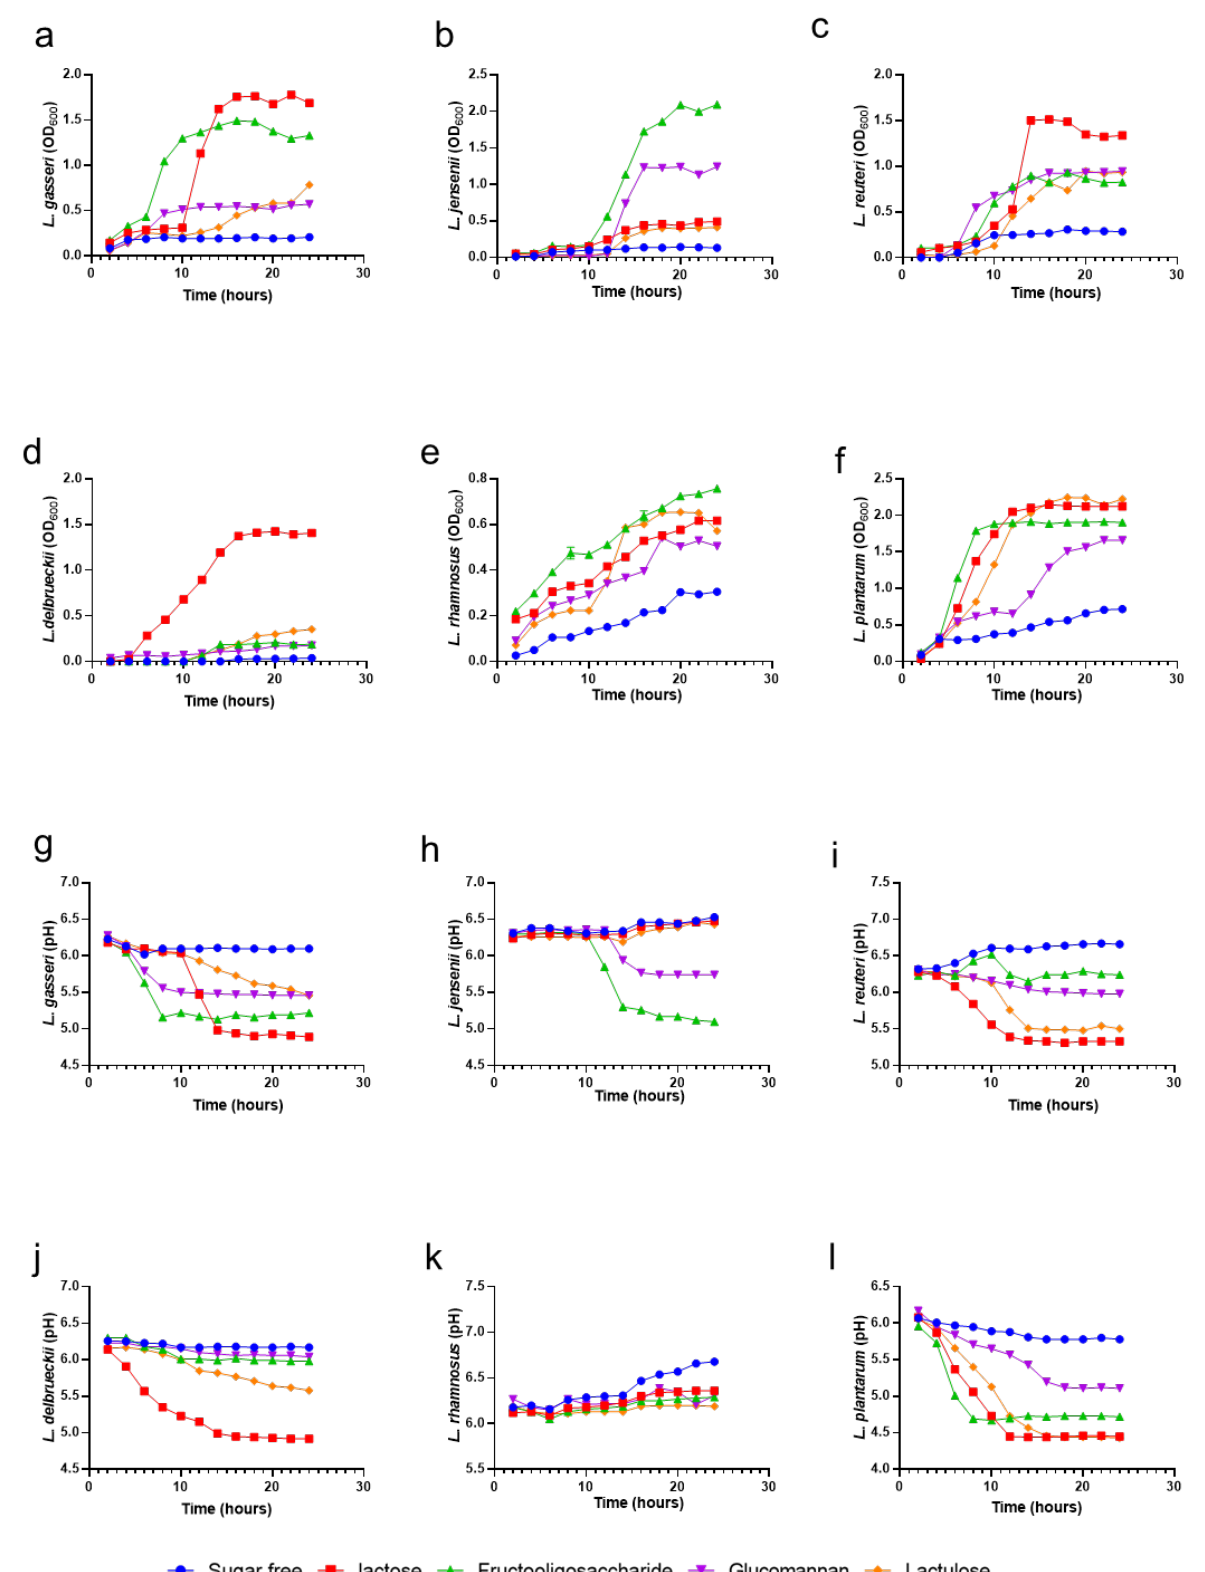
Figure 3. Growth curves and pH changes of vaginal lactobacilli cultured with different prebiotics. ( a – f ). Growth curves of various probiotics in medium with different prebiotics. ( g – l ). The pH changes of various probiotics in medium with different prebiotics.